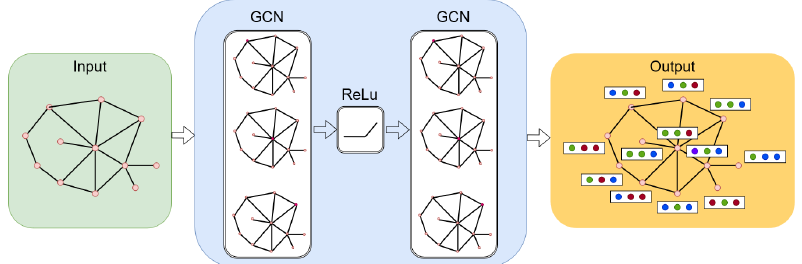
Figure 2. Illustration of graph convolutional neural